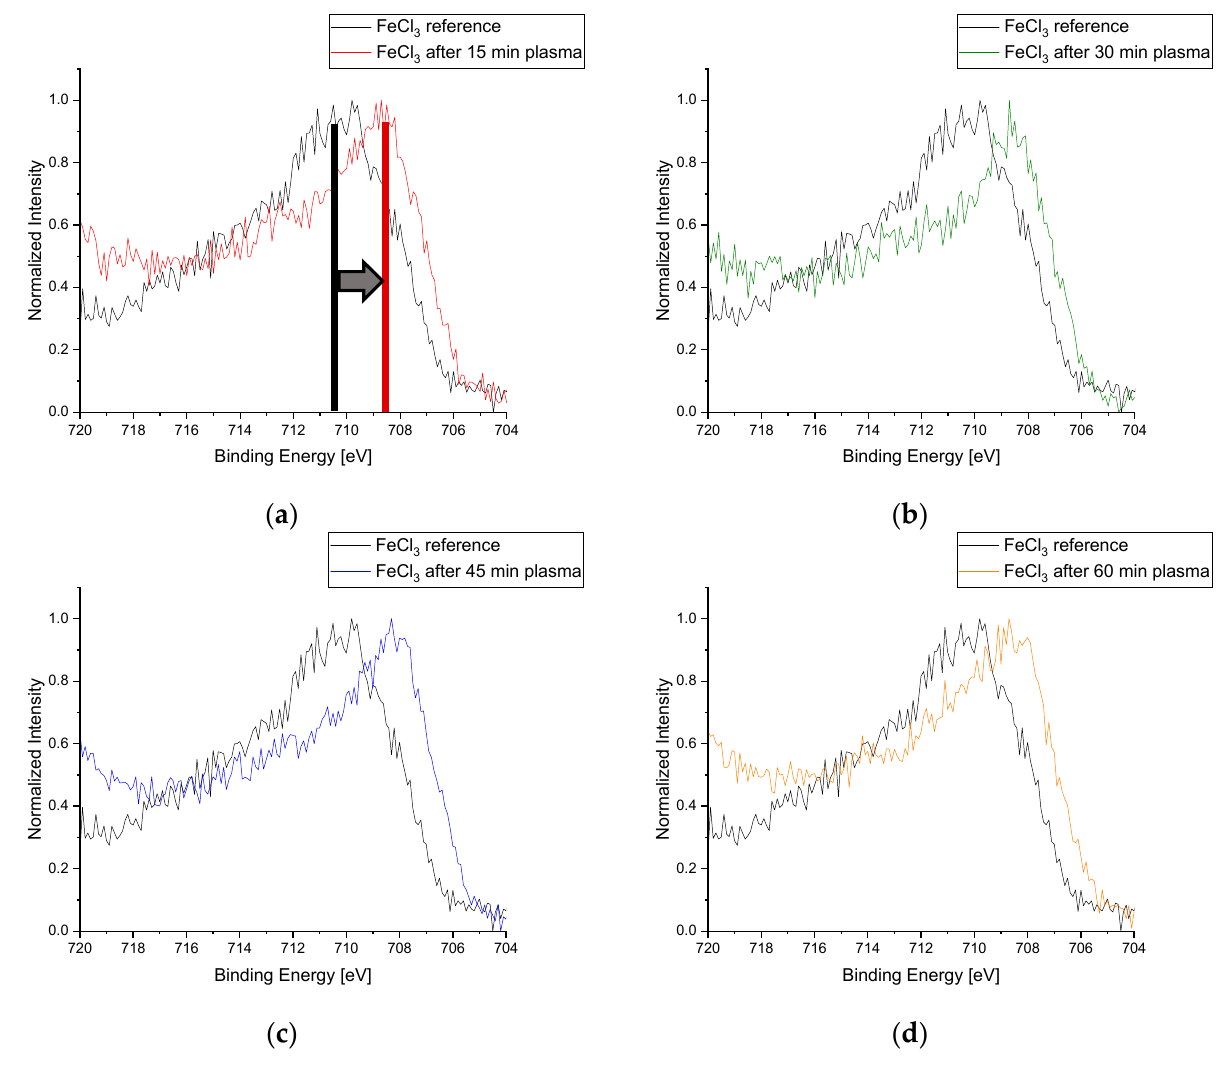
Figure 14. Plot of the respective Fe-2p 3 signal of iron(III) chloride after 15 ( a ), 30 ( b ), 45 ( c ), and 60 min ( d ) treatment time at a low pressure with Varigon plasma compared to the reference (black signals in the plots). The clearly visible shift of the plasma-treated samples from the reference sample to lower binding energies proves the plasma-reduction effect on FeCl 3 layers. The color columns in picture ( a ) visualize the peak positions before (black column) and after plasma treatment (red column) to illustrate the peak shift (arrow).